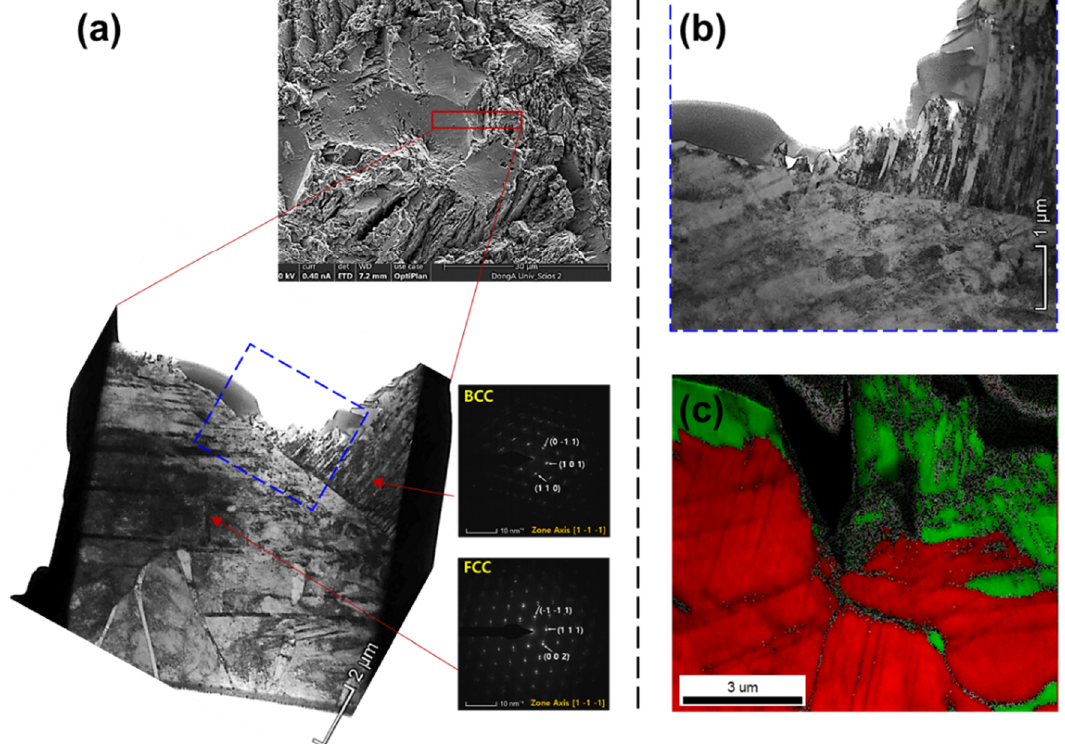
Figure 10. Field-emission transmission electron microscopy (FE-TEM) images of DF_HC where intergranular fracture occurred: ( a ) Focused ion- beam SEM and FE-TEM images with diffraction pattern; ( b ) enlarged FE-TEM bright field image; and ( c ) EBSD phase map of DF_HC.